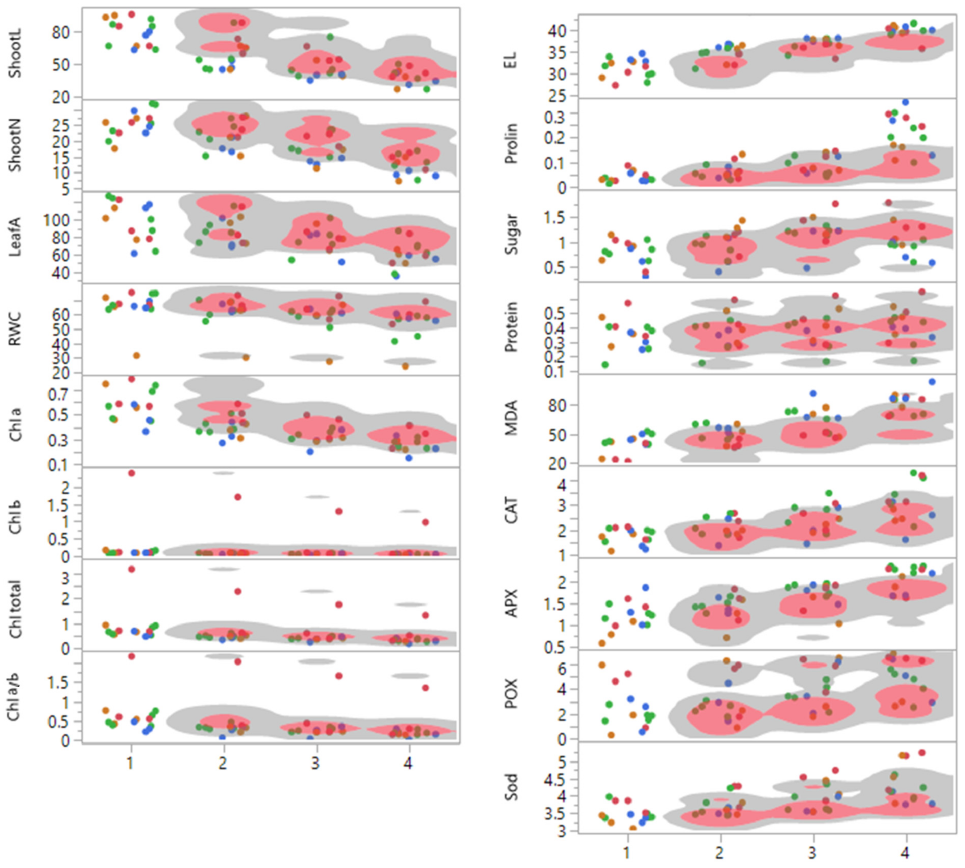
Figure 1. Response of grapevine cultivars to different water shortage regimes. On the x -axis, from one to four, respectively: 100 (control), 75, 50, and 25% of water requirement. Shoot length (Shoot L), shoot number (Shoot N), leaf area (Leaf A), relative water content (RWC), chlorophyll a (Chl a ), chlorophyll b (Chl b ), chlorophyll total (Chl total), chlorophyll a/b (Chl a/b ), electrolyte leakage (EL), malondialdehyde (MDA), catalase (CAT), ascorbate peroxidase (APX), peroxidase (POX), and superoxide dismutase (Sod). Red (tolerant cultivars), green (semi-tolerant), blue (semi-sensitive), and orange (sensitive) .